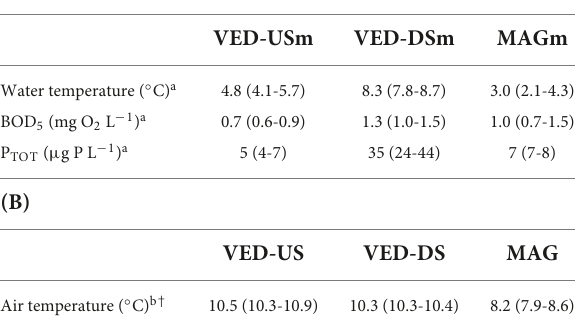
TABLE 2 (A) Differences in water temperature and water chemistry (biochemical oxygen demand, BOD 5 , and total phosphorus, P TOT